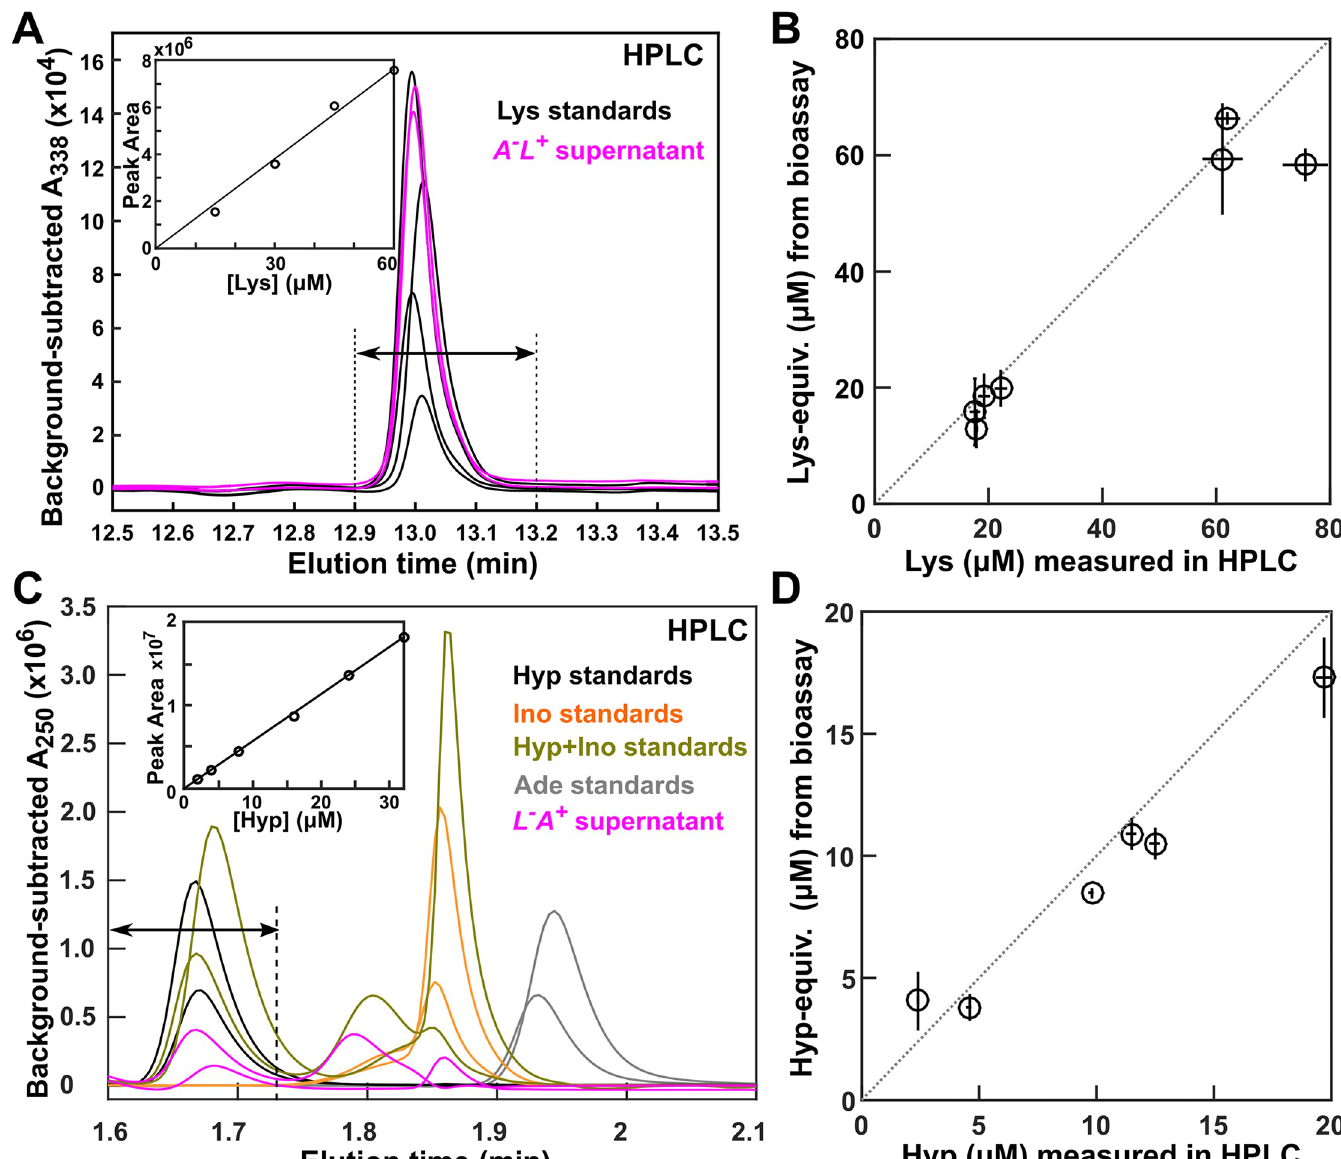
Fig 2. Lysine and hypoxanthine mediate interactions in CoSMO. ( A, B ) Lysine mediates the interaction from A − L + to L − A + . ( A ) A − L + releases lysine. Supernatants of A − L + (magenta) as well as SD supplemented with various concentrations of lysine standards (black) were derivatized and run on HPLC (Methods, “HPLC”). Inset: standard curve on which the peak areas between 12.9 min and 13.2 min (arrows) were plotted against lysine concentrations. ( B ) In A − L + supernatants, lysine concentrations quantified by HPLC agreed with concentrations of lysine equivalents that supported L − A + in a yield bioassay (Methods, “Bioassays”). Circles indicate average values, and bars represent the spread of two measurements. ( C, D ) Hypoxanthine mediates the interaction from L − A + to A − L + . ( C ) L − A + releases hypoxanthine and inosine. HPLC traces of L − A + supernatants (magenta) and standards of SD supplemented with two different concentrations of hypoxanthine (black), inosine (orange), adenine (gray), or a mixture of hypoxanthine and inosine (olive). Inset: standard curve on which the peak areas in the window between 1.6 min and 1.732 min (arrows) were plotted against hypoxanthine concentrations and used to quantify hypoxanthine. Because the HPLC elution profile could vary between independent runs (e.g., compare the two olive curves), quantification windows were adjusted accordingly. ( D ) In L − A + supernatants, hypoxanthine concentrations quantified by HPLC agreed with concentrations of purines that supported A − L + growth as quantified by the yield bioassay. In B and D , dotted lines have a slope of 1. All data can be found in S2 Data. Ade, adenine; CoSMO, Cooperation that is Synthetic and Mutually Obligatory; HPLC, high-pressure liquid chromatography; Hyp, hypoxanthine; Ino, inosine; Lys, lysine; SD, Synthetic Dextrose minimal